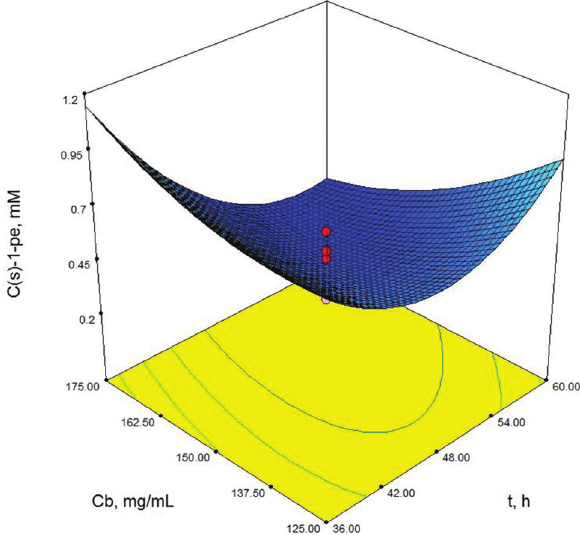
Figure 4: Contour-plot of ( S )-1-phenylethanol concentration: The effect of time and biocatalyst concentration. Other variable is held = 10 mM, C = 30 mM. at zero level. C so g